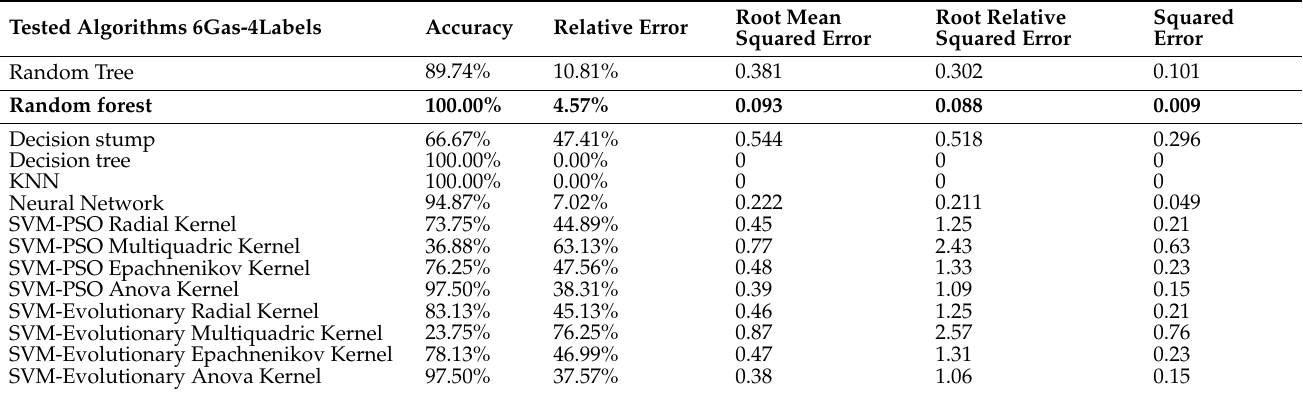
Table 3. 6 Gas dataset comparative